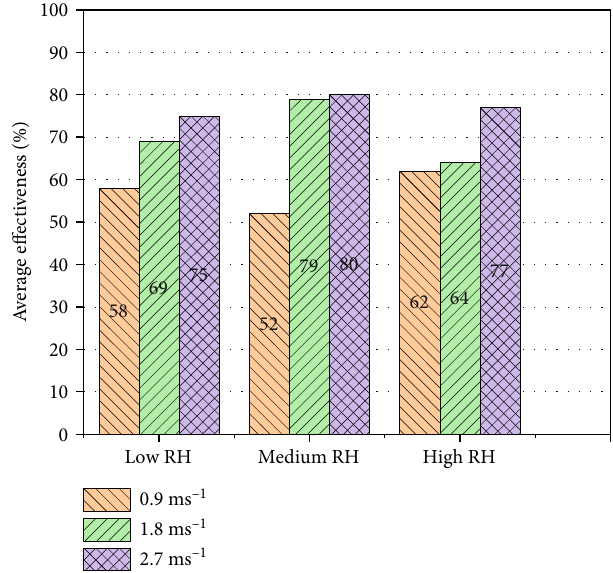
Figure 14: Average e ff ectiveness of the air cooler at three di ff erent velocities under three di ff erent RH